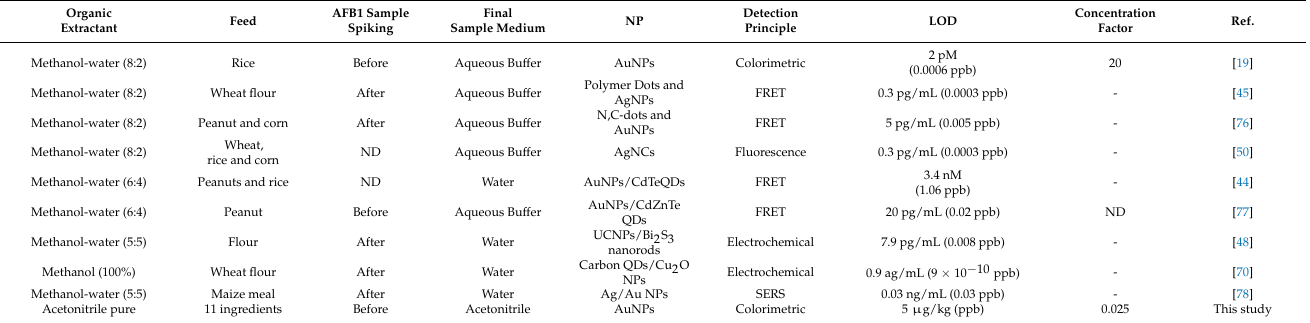
Table 2. AFB1 detection assays for feed samples based on different types of nano-aptasensors. Organic Extractant NP